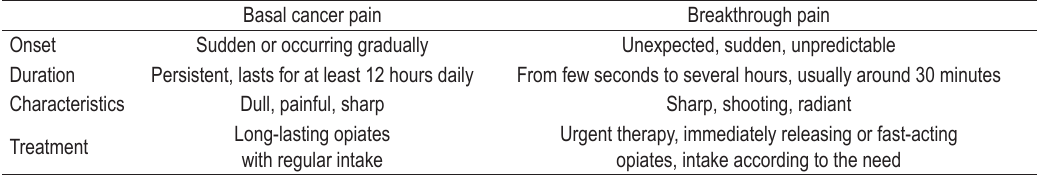
TABLE 1. Differentiation of basal cancer and breakthrough